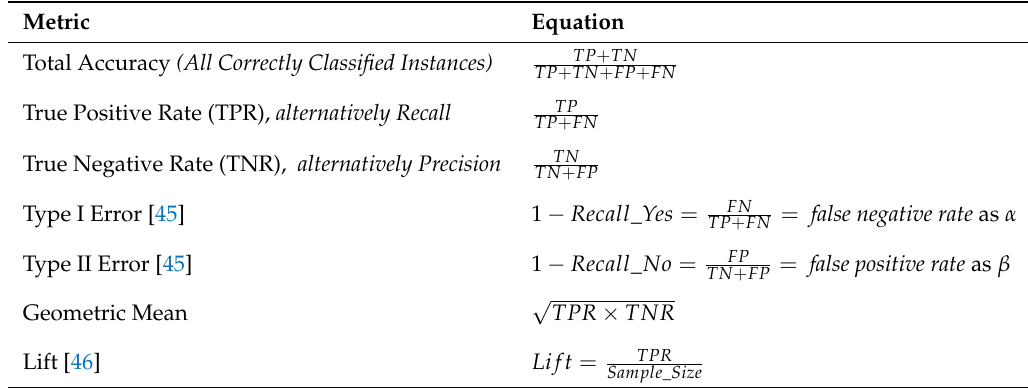
Table 6. Evaluation metrics that are used in this research.